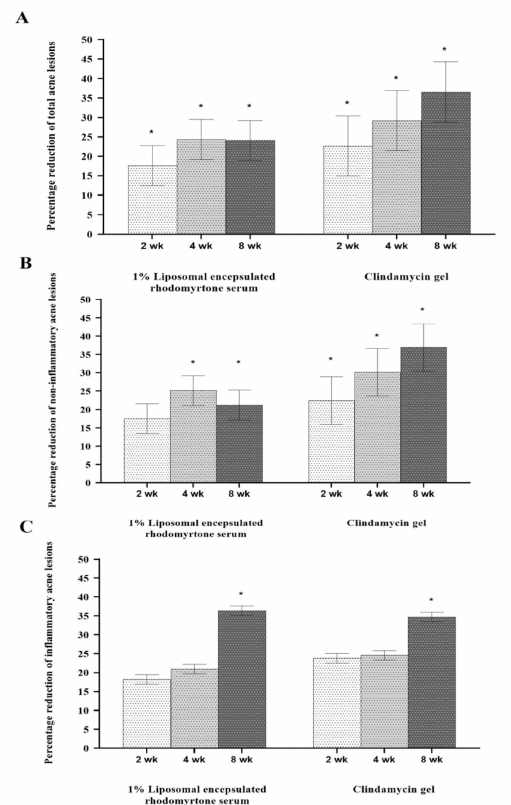
Figure 2. Percentage reduction in mean number of acne lesions after treatment with 1% liposomal encapsulated rhodomyrtone serum and 1% clindamycin gel at weeks 2, 4, and 8. Total acne lesions ( A ), non-inflammatory acne lesions ( B) , and inflammatory acne lesions ( C) . * Statistically different between the baseline and each time point of treatments ( p < 0.05).